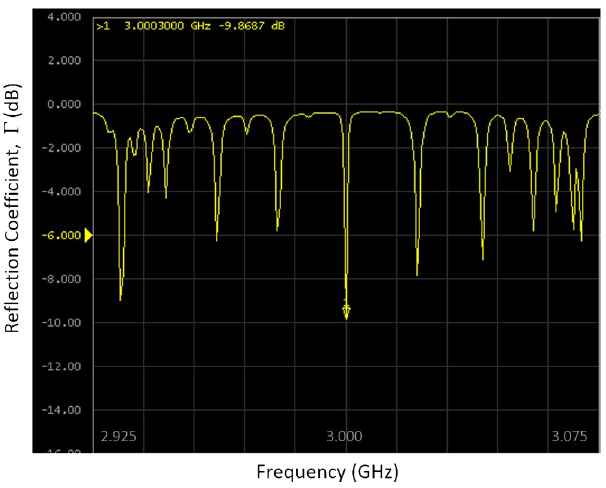
FIG. 15. Reflection coefficient Γ in dB of the FLASH linac from the vector network analyzer. The frequency scale is 15 MHz per